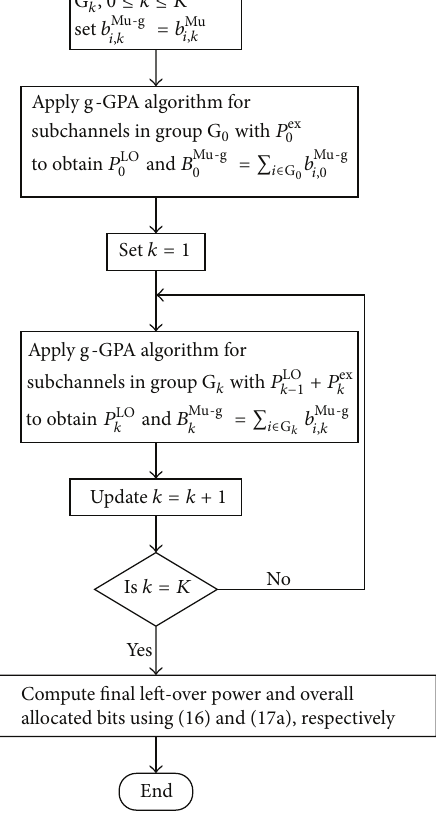
Figure 2: Flowchart of the Mu-GPA